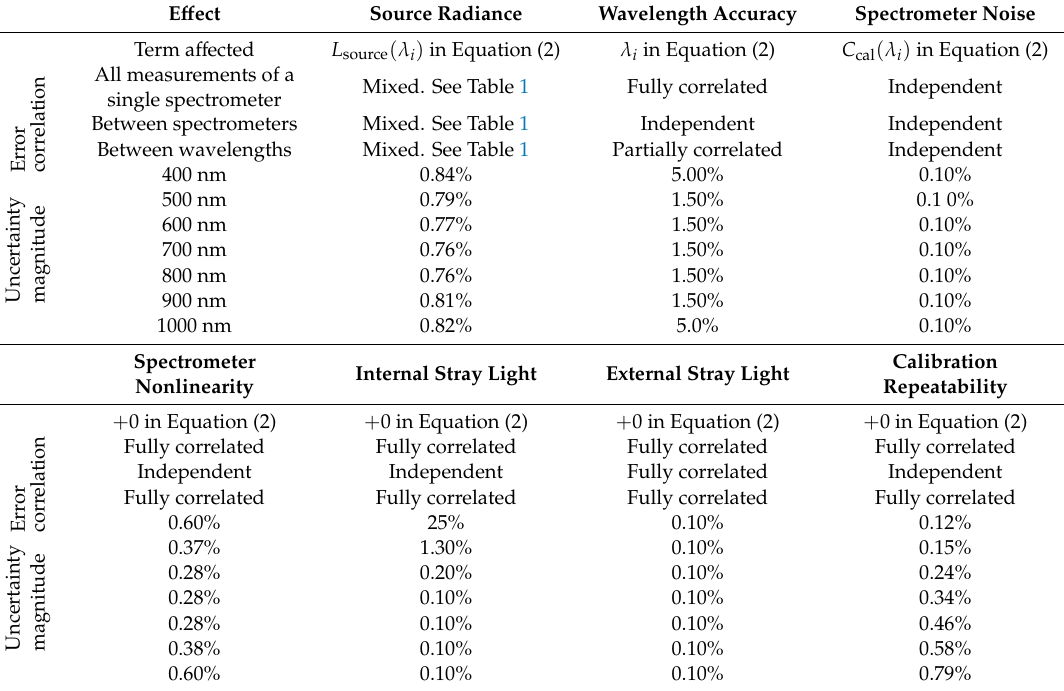
Table 2. Uncertainties associated with laboratory calibration of the